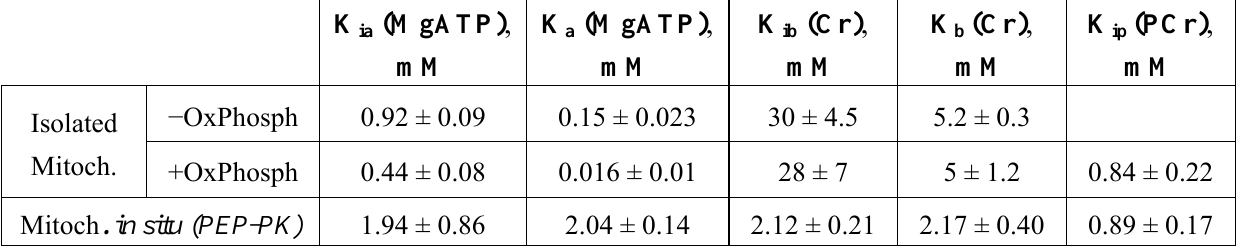
Table 2. Kinetic properties of MtCK in situ in cardiomyocytes. Values of constants for isolated mitochondria are taken from literature [22]. In isolated mitochondria the oxidative phosphorylation decreases dissociation constants of MgATP from MtCK- substrates complexes suggesting the privileged up-take of all ATP by MtCK. In mitochondria in situ in permeabilized cardiomyocytes the increase of apparent constants of dissociation of MgATP compared with in vitro mitochondria shows the decrease of apparent affinity of MtCK in situ for extramitochondrial MgATP. The decrease of apparent constants of dissociation of creatine from MtCK-substrates complexes suggests the increase of the apparent affinity of MtCK for creatine in situ . The apparent constant of dissociation for PCr did not change in situ compared with isolated mitochondria. Reproduced from [29] with